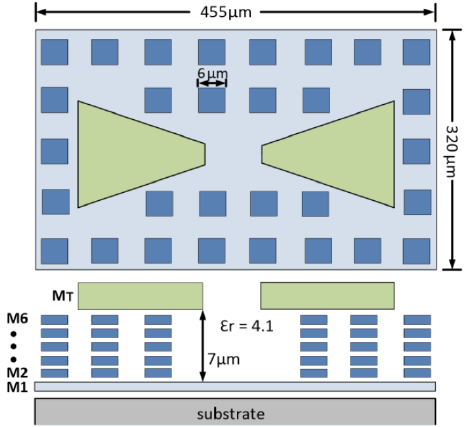
Figure 3. Design of the differential bow-tie antenna in the adopted 150-nm CMOS